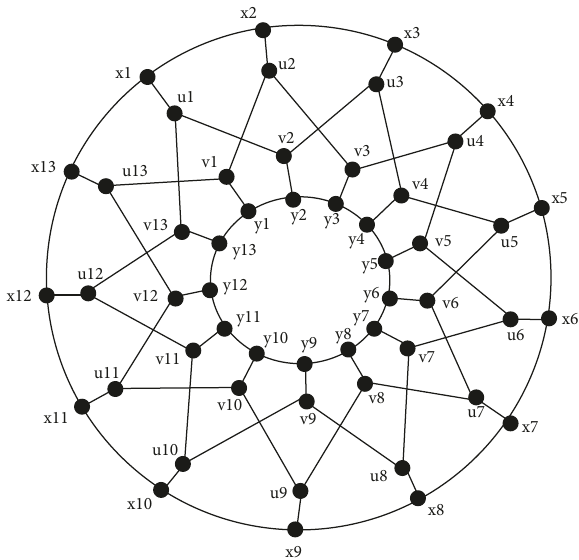
Figure 1: The graph ofDGP ( 13 , 1 ) . Table 1: Codes of outermost edges, e � x